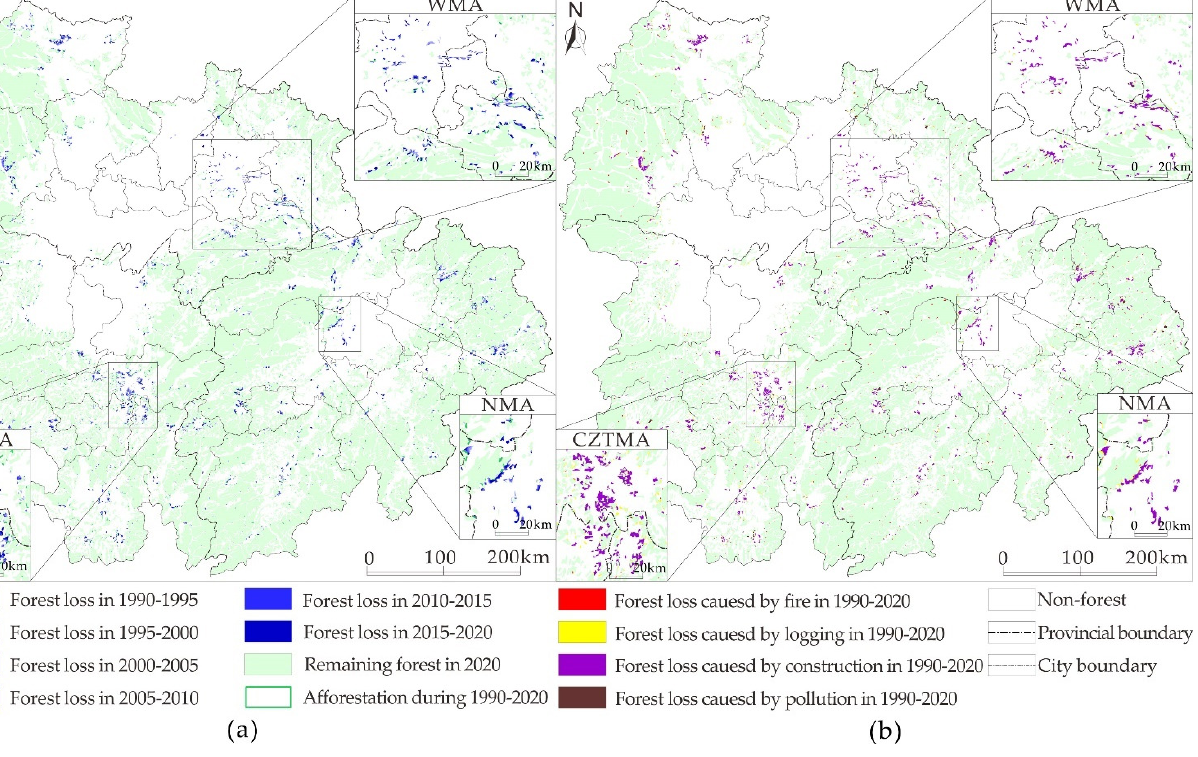
Figure 5. Spatiotemporal loss of forest in UAMRYR: ( a ) forest loss in 6 periods during 1990–2020; ( b ) distribution of forest losses caused by various reasons during 1990–2020.